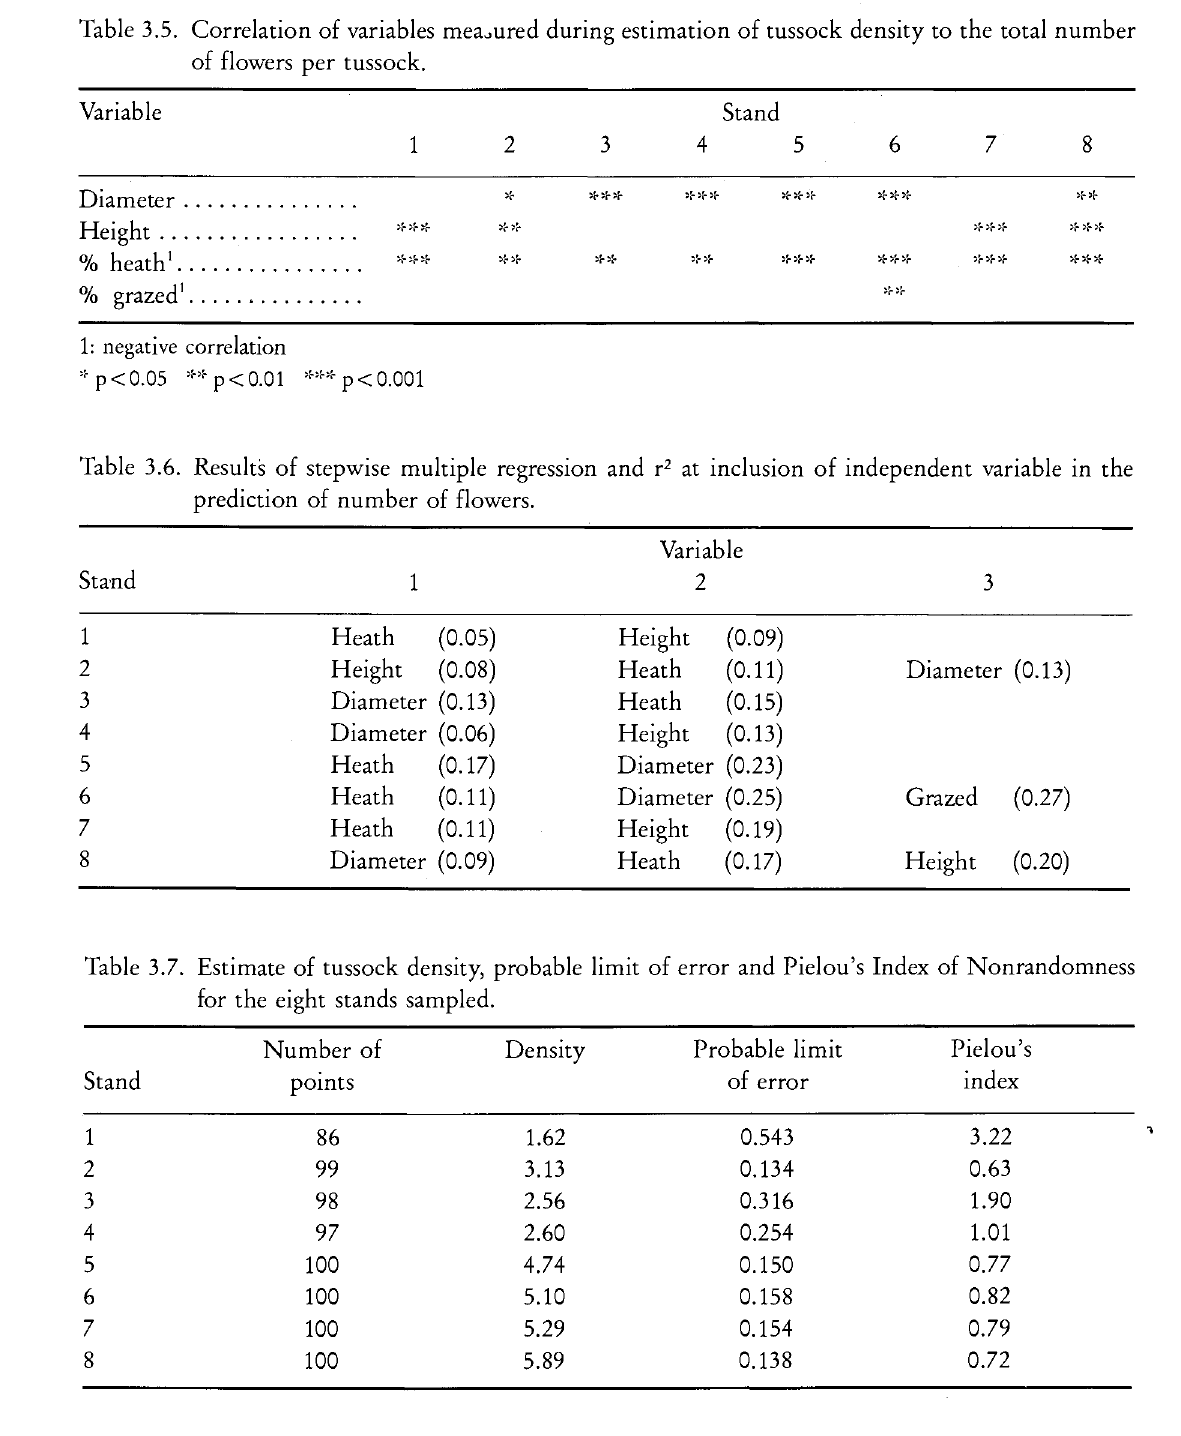
Table 3.5. Correlation of variables meajured during estimation of tussock density to the total number of flowers per tussock.